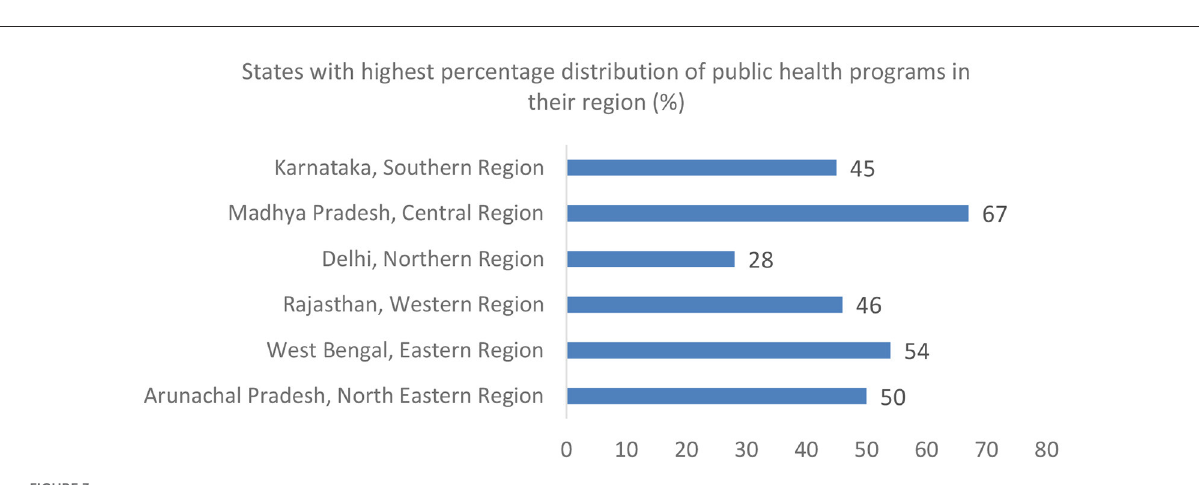
FIGURE3 States offering most of the public health programs within their